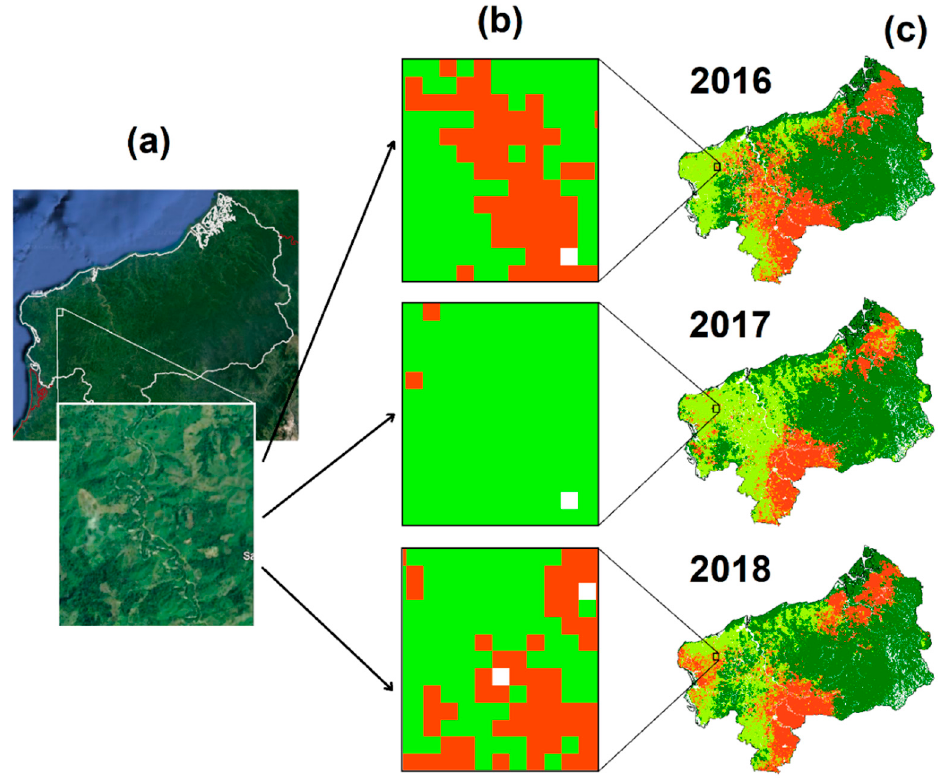
Figure 6. ( a ) True color satellite image of the area of study, with an enlarged square area dominated by low vegetation. ( b ) Enlargement of the classification map corresponding to the area of the square panel of the image ( a ). ( c ) SAR + SRB classification maps of the three years analyzed. The enlargement square of the 2017 map corresponds with the real land-cover type, while, in 2016 and 2018, the pixels were incorrectly assigned mostly as palm plantation.